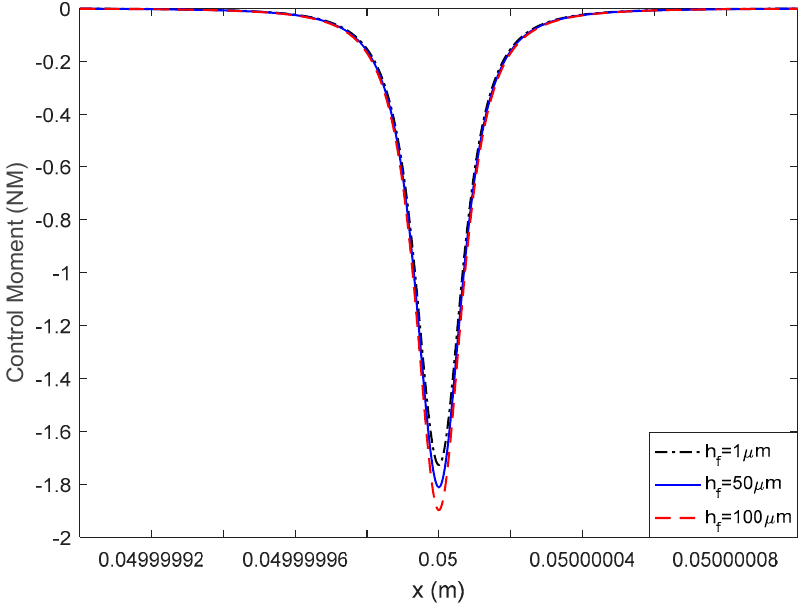
Figure 6. The e ff ect of the flexoelectric patch thickness on the control Figure 6. The effect of the flexoelectric patch thickness on the control moment.